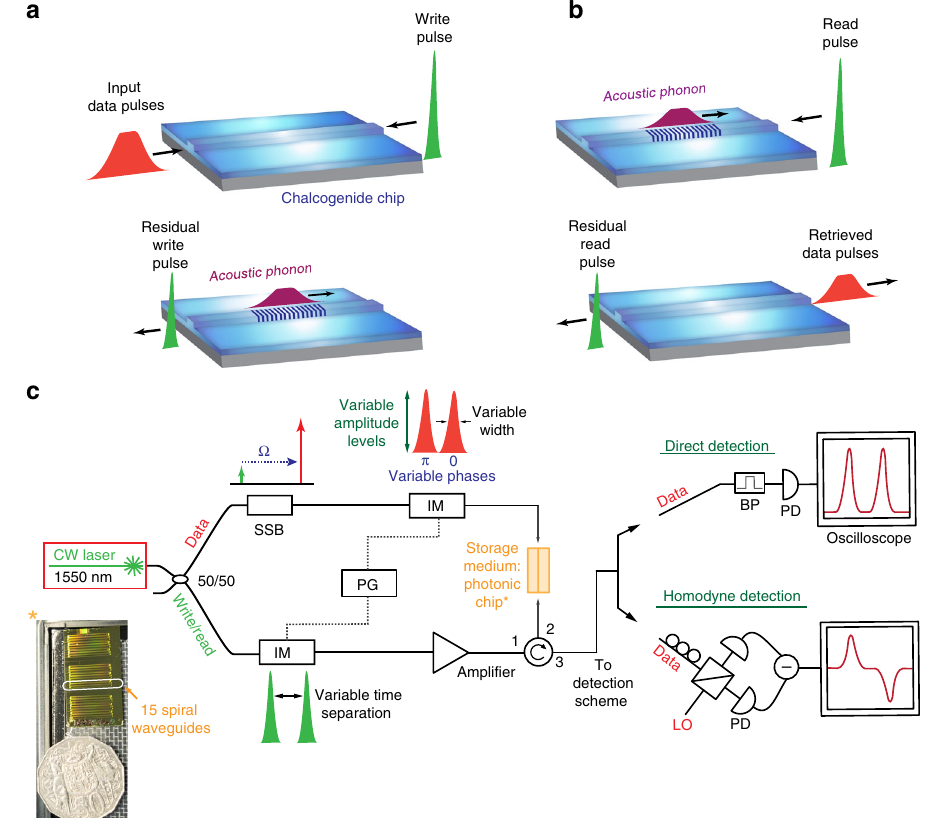
Fig. 1 Basic principle and setup of the photonic – phononic memory. a Storing process: an optical data pulse is depleted by a strong counter-propagating write pulse, storing the data pulse as an acoustic phonon. b Retrieval process: in the retrieval process a read pulse depletes the acoustic wave, converting the data pulse back into the optical domain. c A basic schematic of the experimental setup. The inset shows a chalcogenide chip next to a 50-cent coin. The chip contains more than 100 spiral waveguides with different lengths (8.6, 11.7 and 23.7 cm). Note: this is only a schematic and the actual setup is more advanced and can be found in Supplementary Fig. 1 (CW continuous wave, SSB single-sideband modulator, IM intensity modulator, PG pulse generator, BP bandpass fi lter, PD photo-detector, LO local oscillator, Ω Brillouin frequency